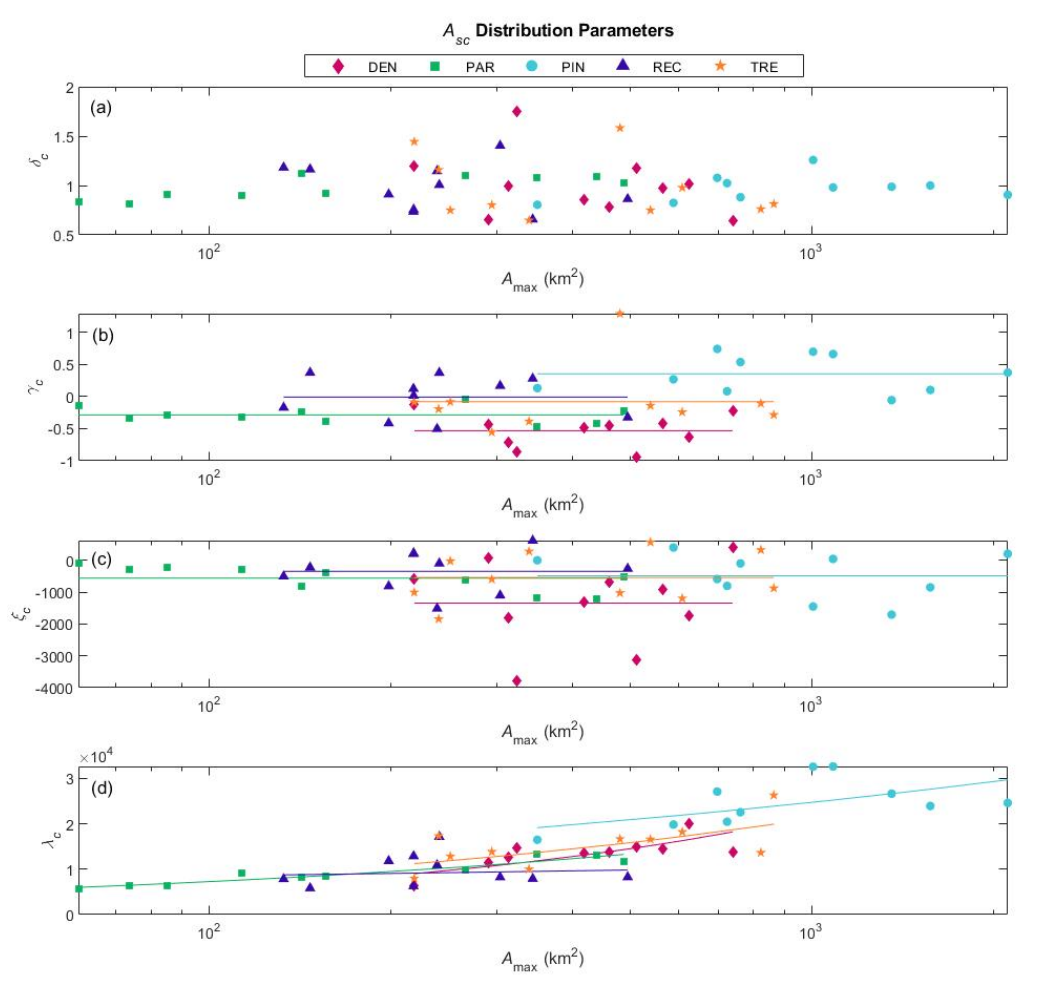
Figure 5. Parameters ( a ) δ c , ( b ) γ c , ( c ) ξ c , and ( d ) λ c of the Johnson SB distribution for A sc plotted against the maximum upstream area A max . The symbols show the calibrated parameter values for each basin. The horizontal lines in ( b – c ) show the average parameter value for each network type. The lines in ( d ) show power functions fitted to the λ c values for each network type.